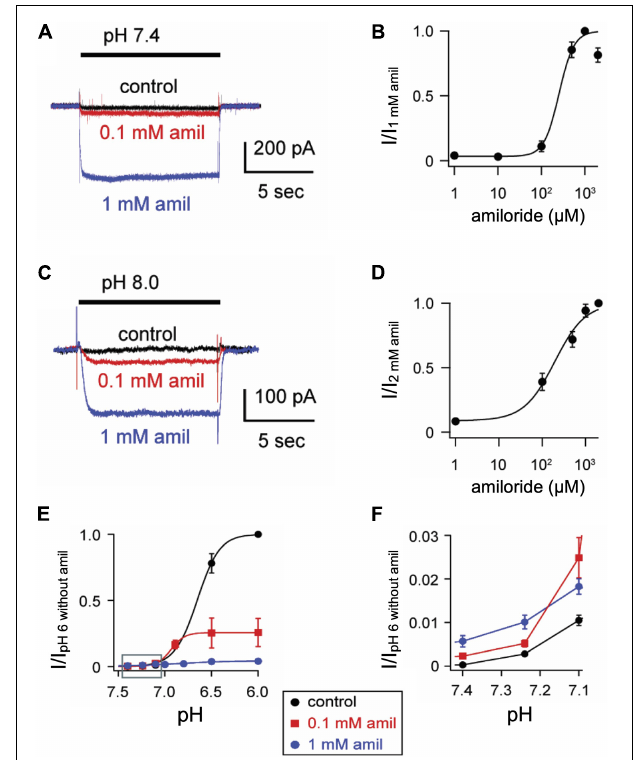
FIGURE 2 | Amiloride increases the pH sensitivity of activation of ASIC3. (A) Representative superimposed ASIC3 currents evoked from a control solution of pH 8.0 (no amiloride) to pH 7.4 (containing the indicated amiloride concentrations at 0, 0.1 mM, and 1 mM). (B) Dose-response curve for amiloride on pH 7.4-evoked currents ( n = 7–11 for each data point). Line is fit of Hill equation (EC 50 = 255 µ M). (C) Representative superimposed currents from a control solution of pH 8.0 (no amiloride) to pH 8.0 (containing the indicated amiloride concentrations). (D) Dose-response curve for amiloride on pH 8.0-evoked currents ( n = 8). Line is fit of Hill equation (EC 50 = 193 µ M). (E) pH dose-response curves for activation in 0 mM (control), 0.1, and 1 mM amiloride. Data are acquired by stepping from pH 8.0 (with 0 mM amiloride) to the indicated test solutions (containing the indicated amiloride concentrations) and are normalized to the peak currents evoked by pH 6.0 in no amiloride ( n = 4–9 for each data point). Lines are fits of Hill equations (pH 50 = 6.7, 6.9, and 6.8 for 0, 0.1, and 1 mM amiloride, respectively). Note the error bars are often smaller than the markers. (F) A graph of the boxed area in (E) with expanded axes demonstrating the potentiating effect of amiloride at the foot of the pH dose-response curves (one-way ANOVAs at pH 7.40 and 7.24 found differences between groups ( p < 0.01), with Dunnit’s multiple comparisons showing p < 0.01 for amiloride 1 mM vs. control at pH 7.40 and